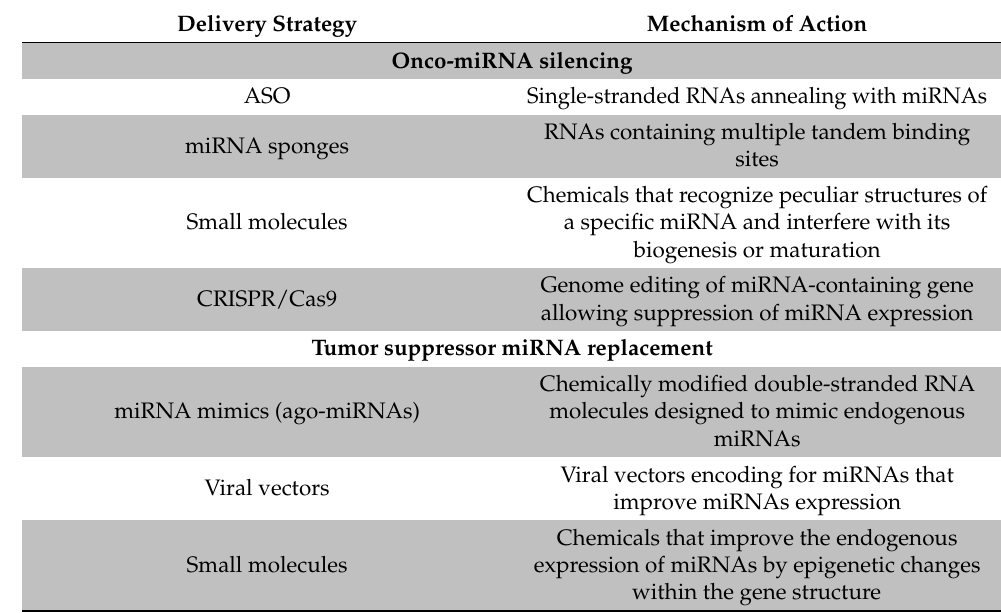
Table 1. miRNA delivery approaches for prostate cancer